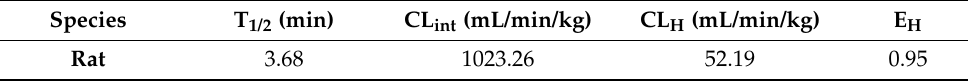
Figure 4. GKB202 remaining versus time profile in SD rat Liver S9. Data is presented in mean values of triplicate measurements. Table 3. Hepatic metabolic stability of GKB202 prediction in SD rat with presence of NADPH.